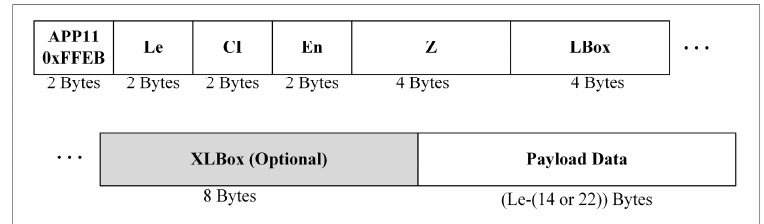
Figure 1. General structure of APP11 marker segment.